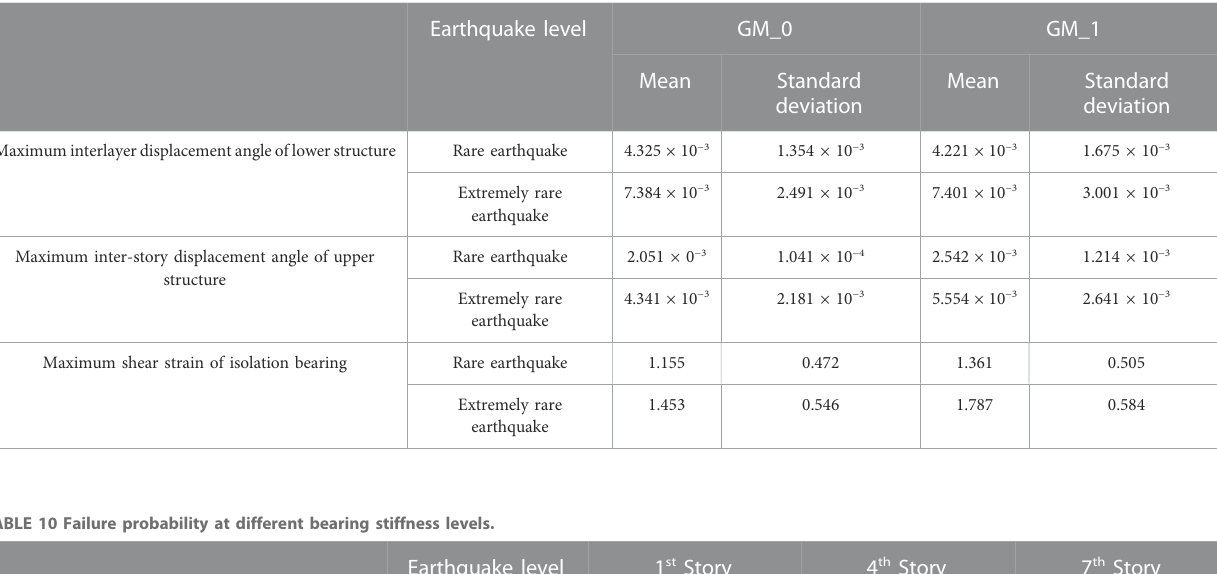
TABLE 9 Probabilistic characteristic parameters of structural response values at 150% stiffness.